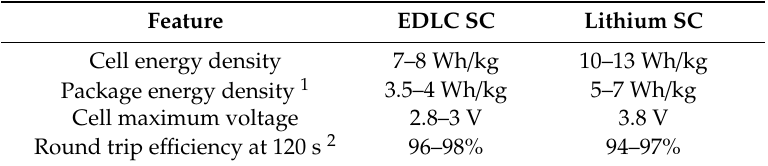
Table 1. Supercapacitor (SC) features.